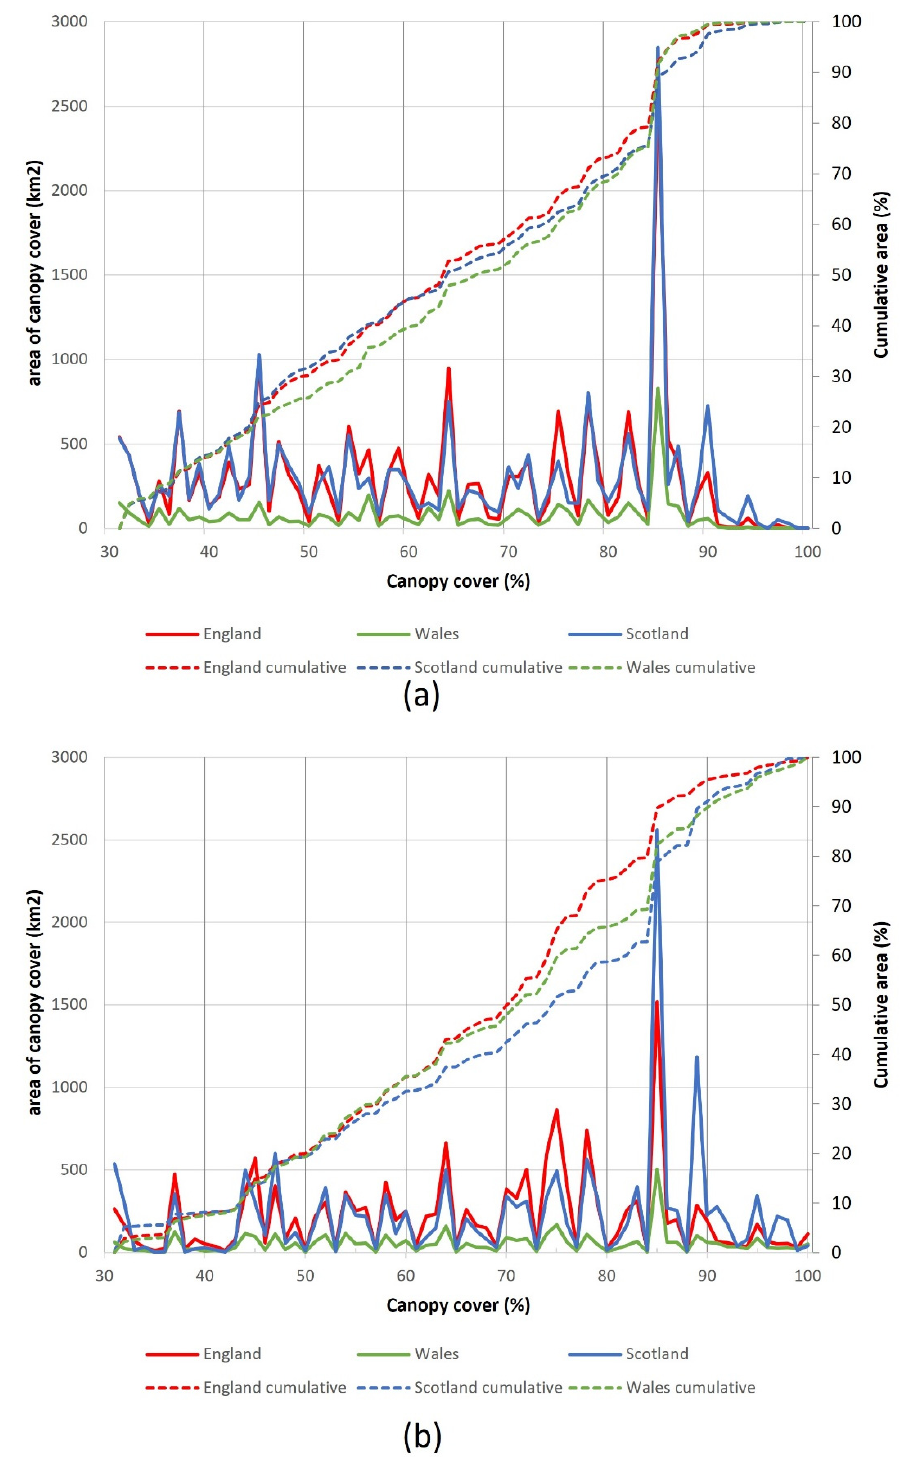
Figure 6. GLAD FC > 30% canopy cover vs. area of cover for ( a ) 2010 and ( b ) 2000. The results of combining the agreement and commission grids from the NFI accuracy assessment with the GLAD FC percentage canopy cover grids showed the same trends as the complete data, i.e., a smaller proportion of the 2000 data having areas below 40% can- opy cover than the 2010 data. The 2010 commission areas show a gradual decrease in can- opy cover with increasing canopy covers (until 90%), whereas the 2000 commission areas only show this decline with increasing canopy cover in the English data. In Scotland and